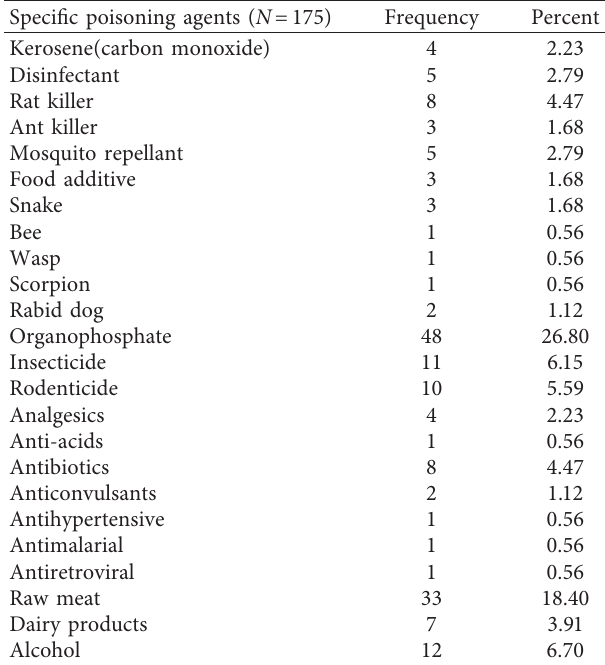
Figure 2: Distribution of poisoning cases by their types of poisoning agents in western Ethiopia, 2018. Table 3: Distribution of poisoning cases by specific poisoning agents in western Ethiopia,